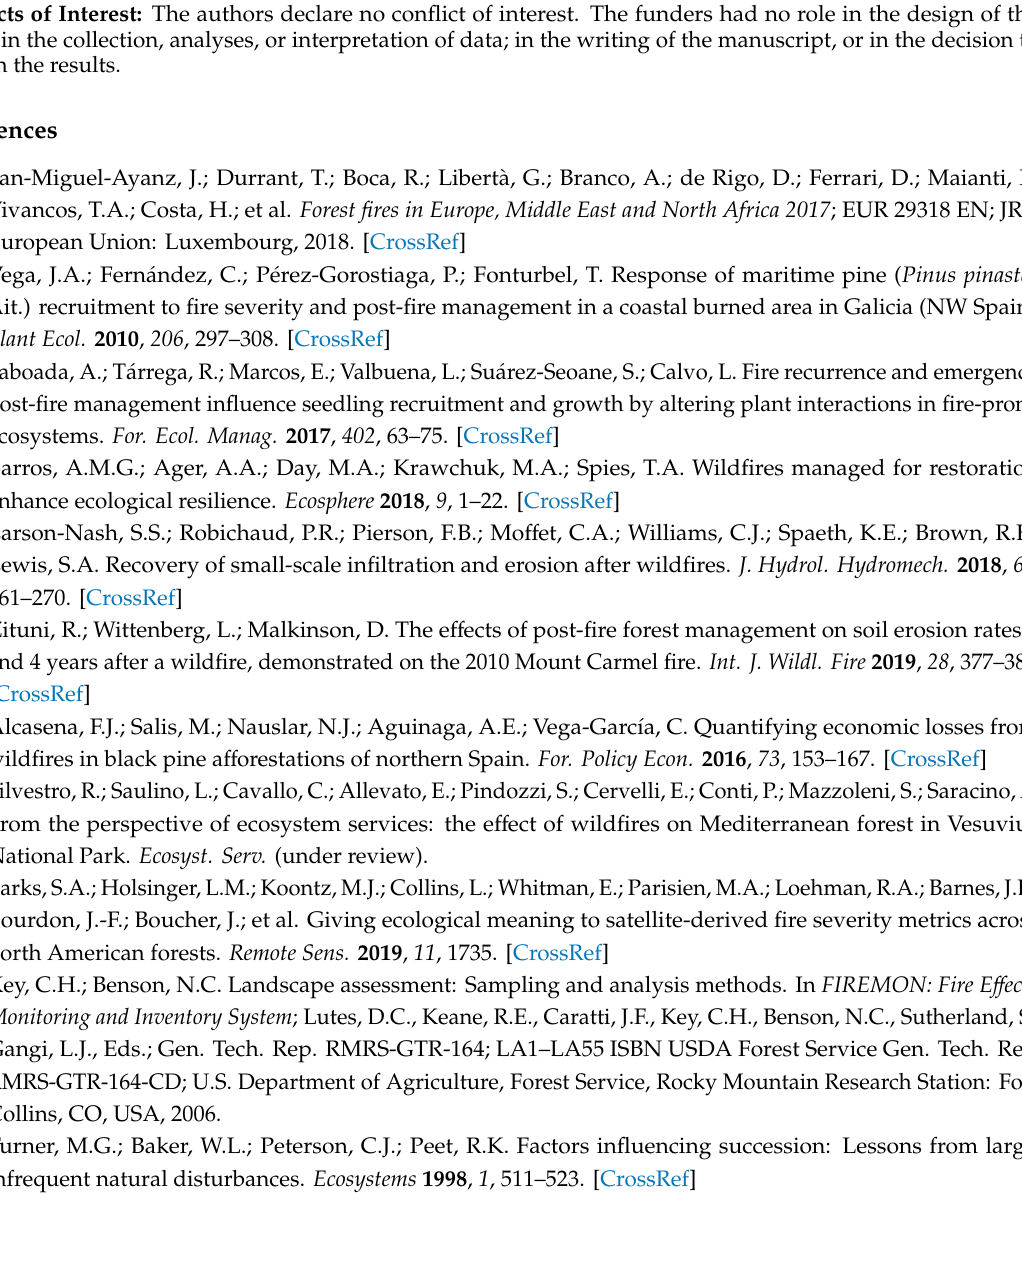
Table S1: Field-based composite burn index categories, range values and descriptions, File S1: Error matrix, Video S1: Fire dynamic in a Pinus pinea stand in the Vesuvius National